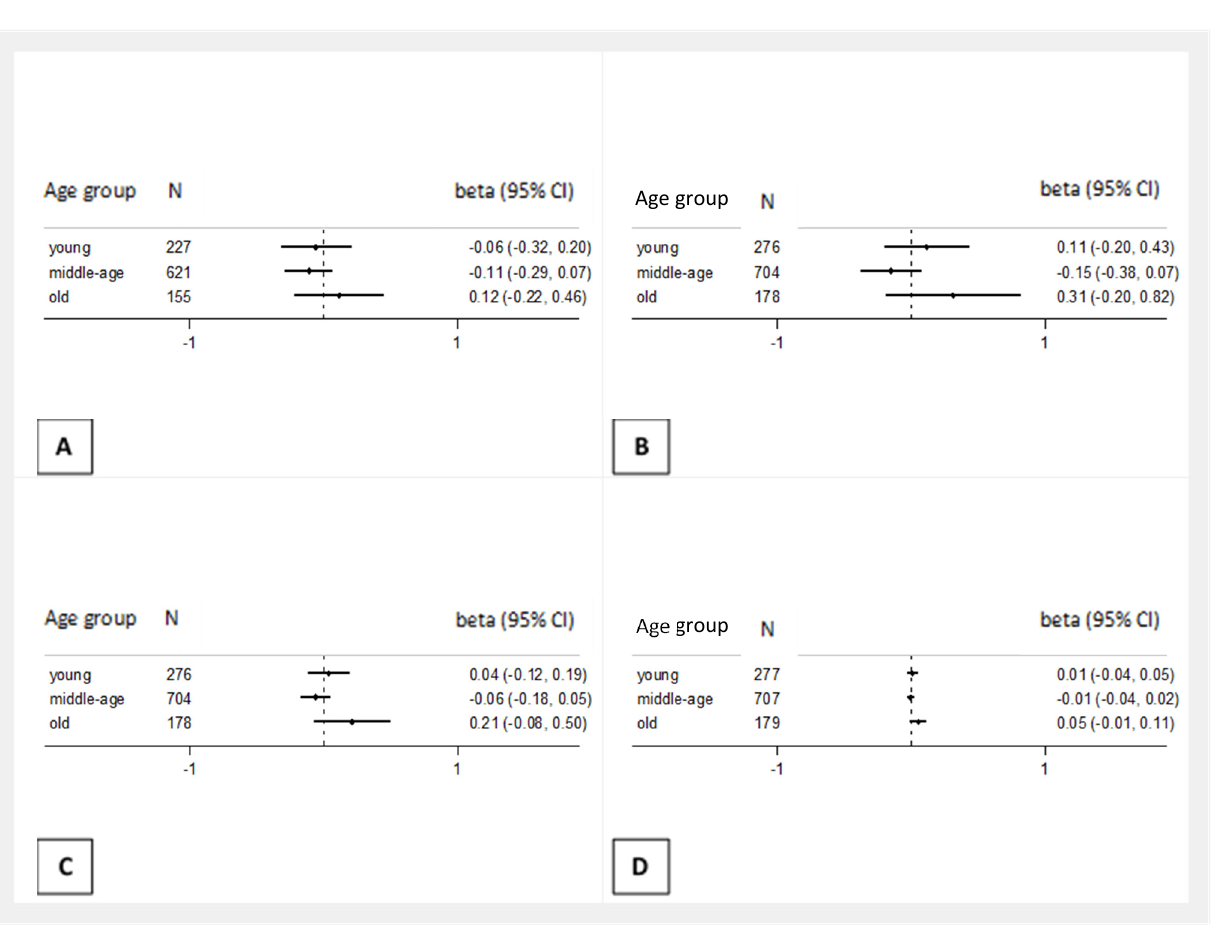
Figure 2. Results from multiple linear regressions for the association between adherence to the Mediterranean diet and the continuous scores of the four cognitive tests, stratified by age among Epirus Health Study participants. Models were adjusted for age (continuous), sex, education, BMI, smoking status, alcohol consumption and physical activity. ( a ) Verbal fluency, phonemic subtest, ( b ) Logical Memory, immediate recall, ( c ) Logical Memory, delayed recall, and ( d ) composite z-score. Young: <40 years, middle-aged: 40–59.9 years, old: >60 years.